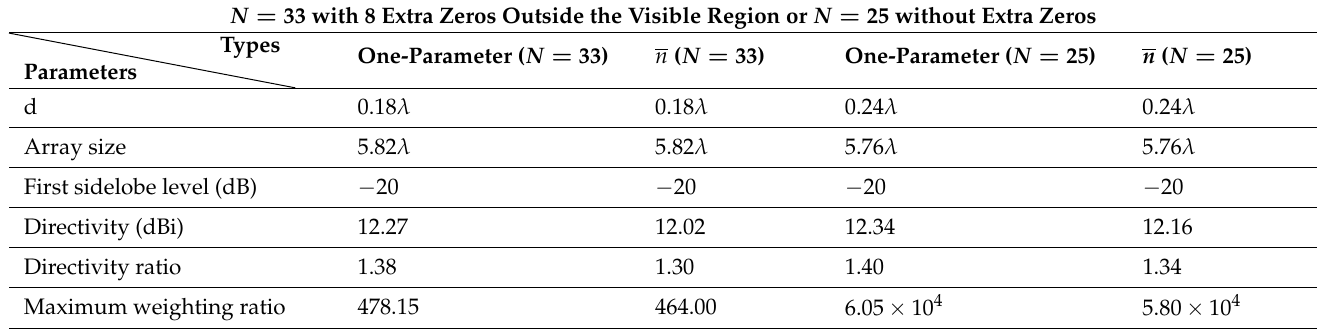
Table 4. Comparison of the two types of Taylor-like super-directive patterns with reduced maximum weighting ratio. N = 33 with 8 Extra Zeros Outside the Visible Region or N = 25 without Extra